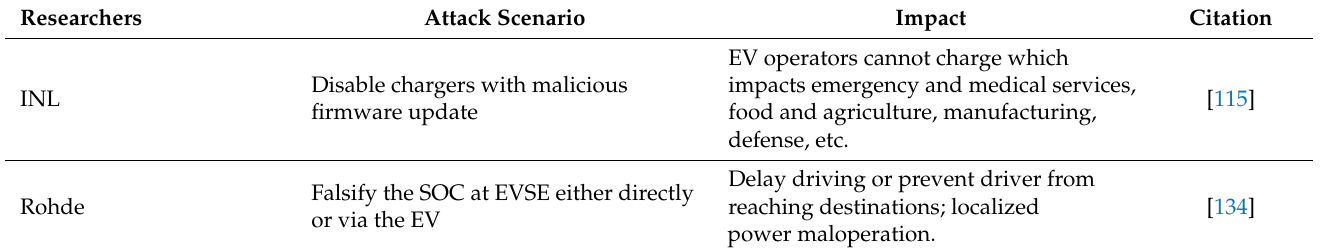
Table 5. Summary of potential EVSE cyberattack